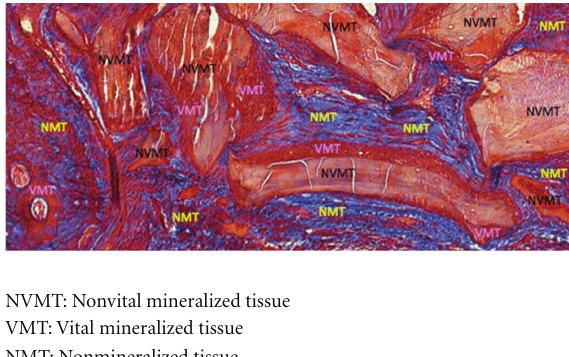
Figure 7: Histological view of NVMT, VMT, and NMT in 100x magnification (Mallory trichrome).